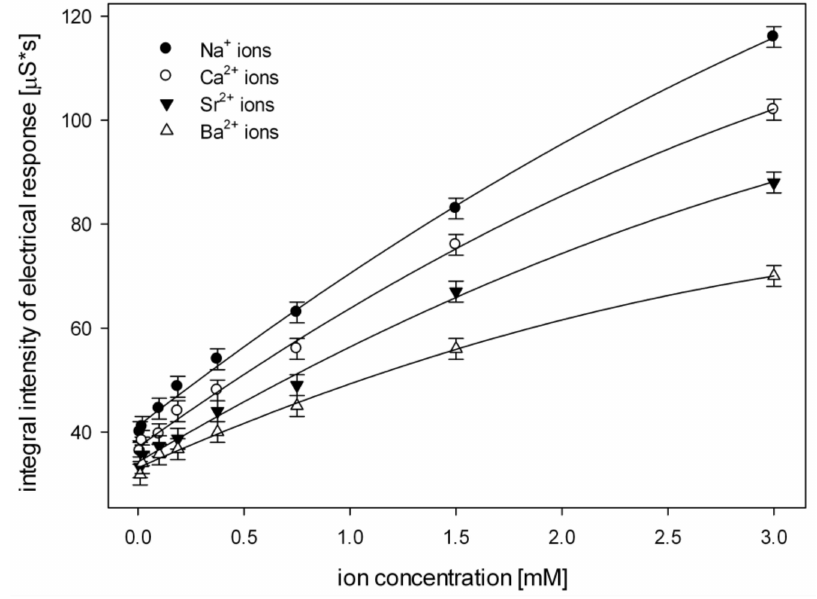
Figure 6. The correlation of the integral intensity of the registered signals and the concentration of Na + , Ca 2+ ,Sr 2+ and Ba 2+